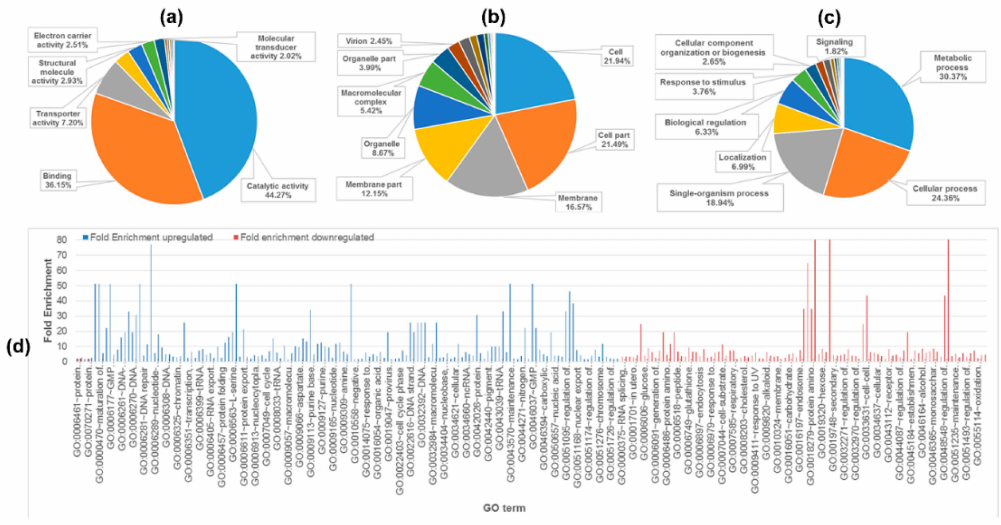
Figure 3. Functional classification and fold enrichment of identified proteins using SWISS-PROT and DAVID databases, based on universal GO annotation terms. Proteins were linked to at least one annotation term within the GO molecular function ( a ); cellular component ( b ); and biological process ( c ) categories; ( d ) Fold enrichment of biological processes in EMT of HCV29 and